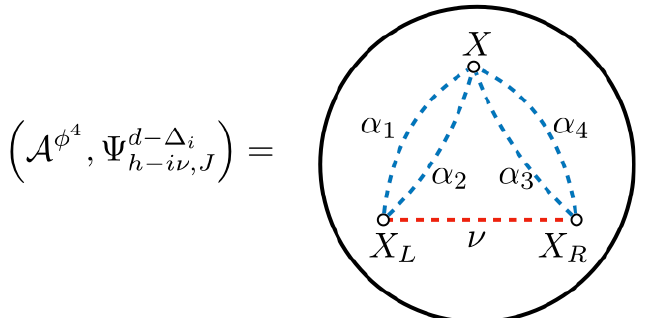
(cid:16) (cid:17) A (cid:30) 4 ; (cid:9) ( s ) as a bulk (cid:23);J